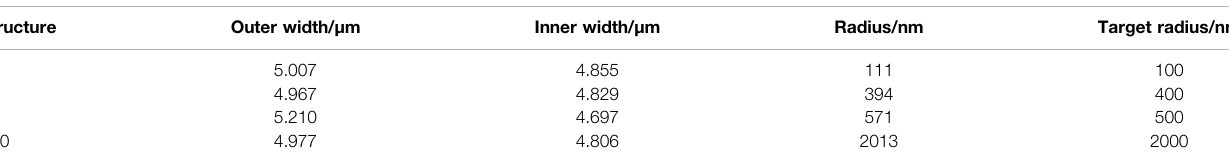
TABLE 2 | Feature sizes of structures in row A, measured by AFM.